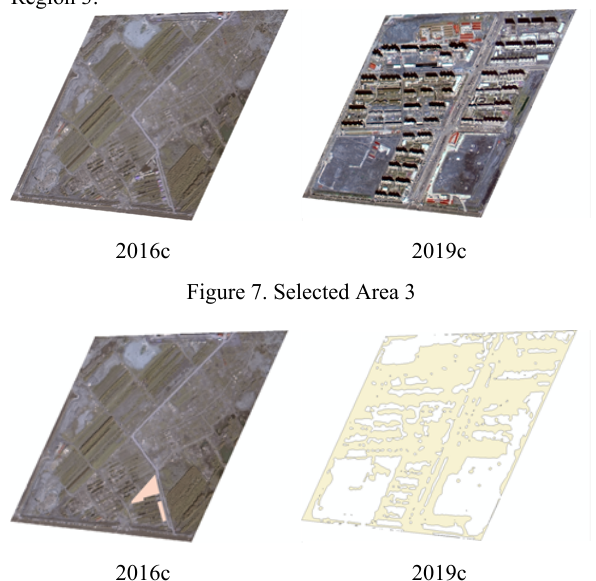
Figure 8. Extraction area 2 impermeable layer